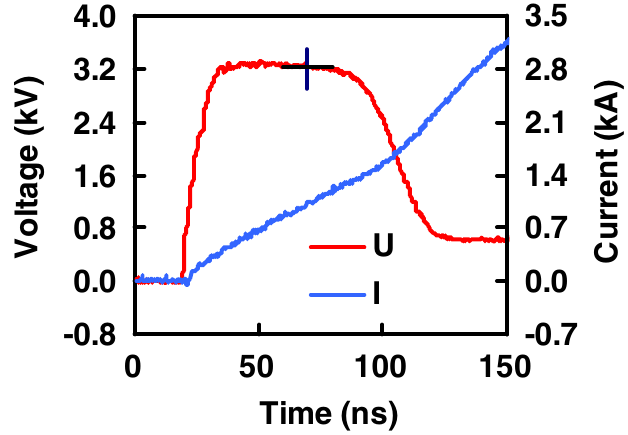
FIG. 4. (Color) Fast voltage pulse and the current in the single- turn winding of a core made of ET3425 iron tape with thickness (cid:1) ¼ 50 (cid:6) m